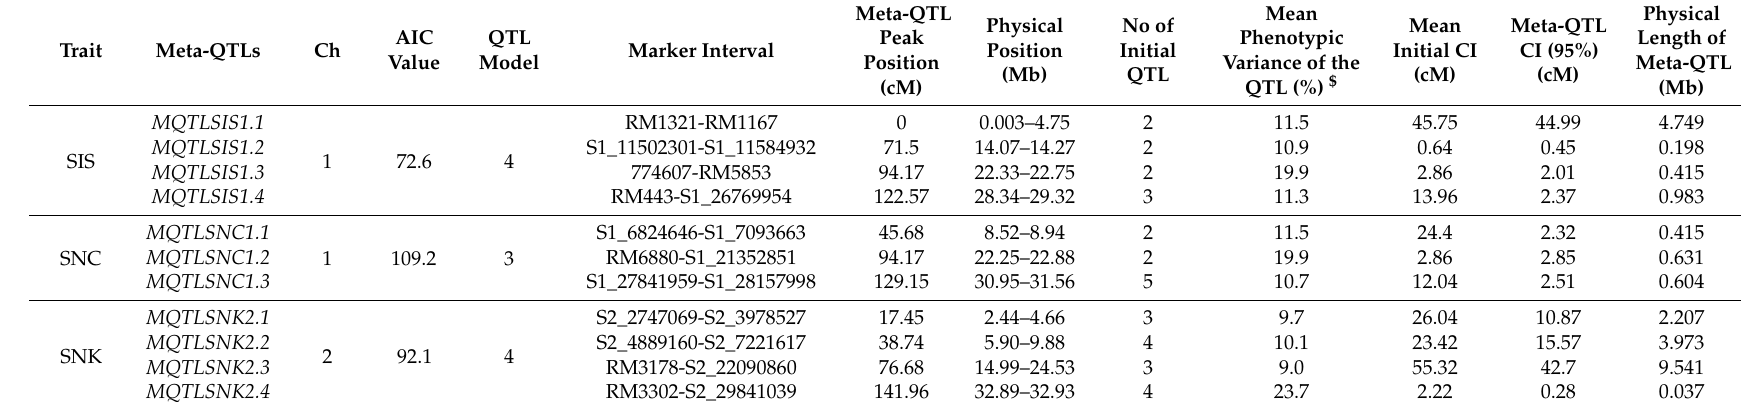
Table 2. Meta-QTLs for seedling-stage salt tolerance traits in